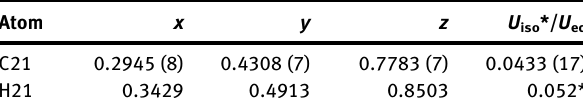
Table  : Fractional atomic coordinates and isotropic or equivalent isotropic displacement parameters (Å 